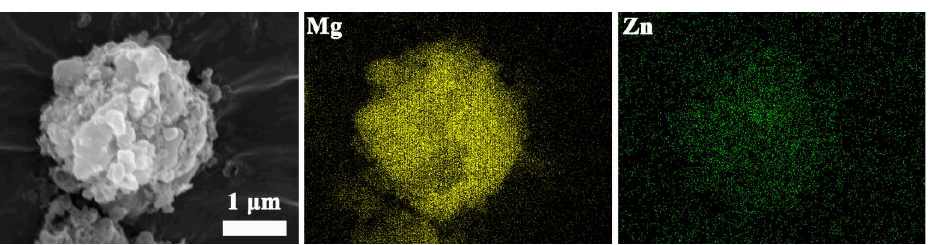
Figure 8. The element mapping images of MgH 2 -5 wt% ZnO composite of ball milling. The element mapping of dehydrogenated MgH 2 -5 wt% ZnO displays the elements of Mg and Zn uniformly distributed which prove the phase change, see Figure 9. The elements mapping of the sample of re-hydrogenated is shown in Figure 10.